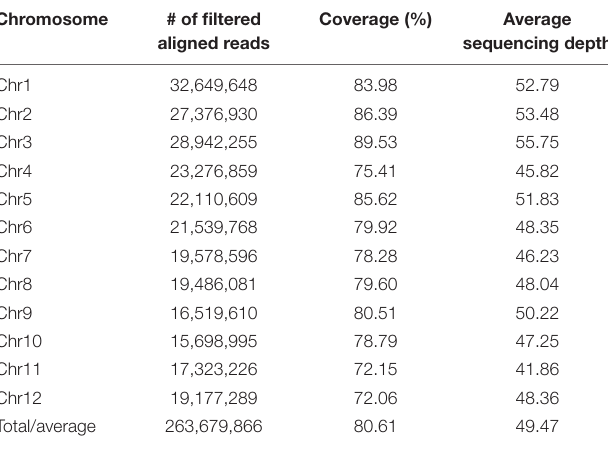
TABLE 1 | Chromosome wise distribution and read statistics of Purpleputtu (PP)